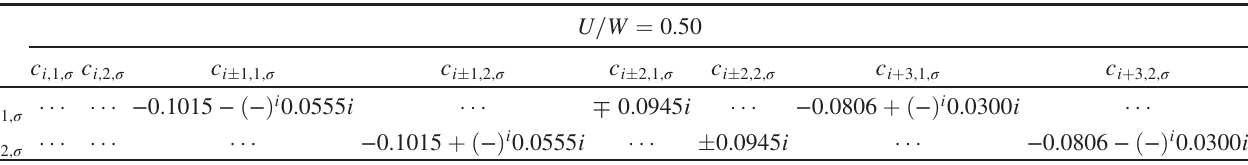
TABLE II. Mean-field renormalization with U=W ¼ 0 . 50 and α ¼ 0 . 45 using the model from Ref. [37]. The input on ½ c † il σ ; c jl 0 σ (cid:4) represents the renormalized mean-field parameter h c † il σ c jl 0 σ i . The result is homogeneous and spin degenerate; hence, the listed values contain information about all sites and flavors. We have subtracted the bare band contributions evaluated at ν ¼ 0 . 5 and ignored all mean = j MF jÞ > 100 fields with ðj MF j max